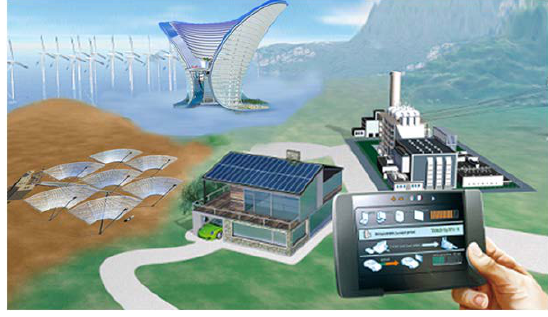
Figure 1. Some of the components of a smart power